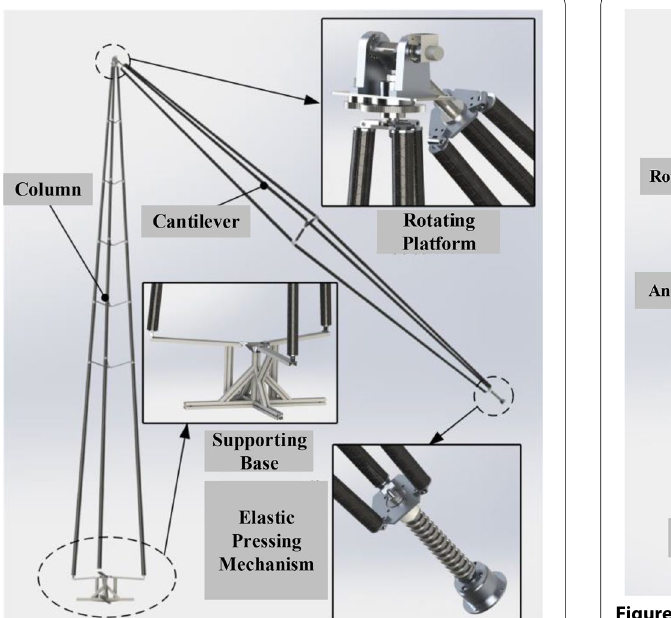
Figure 4 Two-degree-of-freedom rotating platform